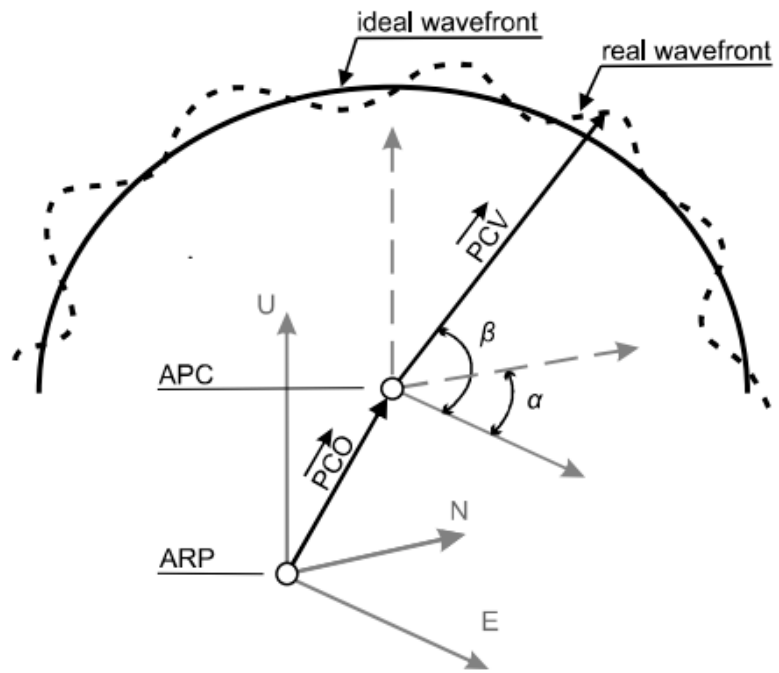
Figure 1. A phase shift due to antenna model change.